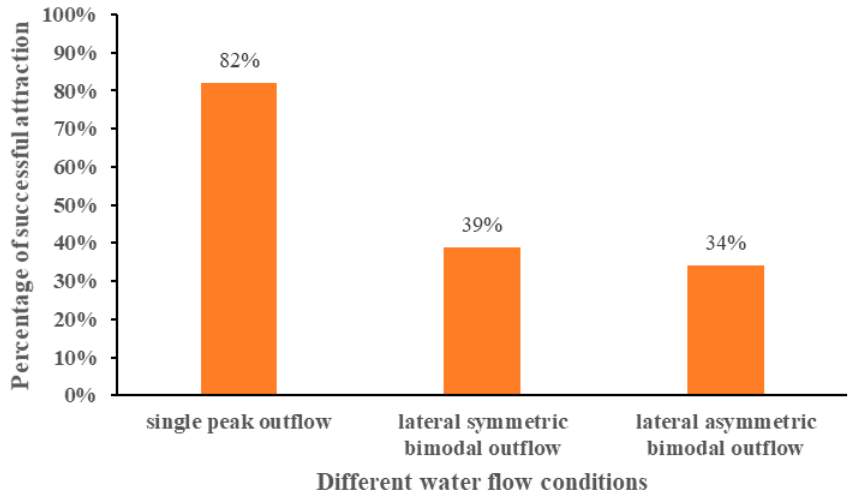
Figure 10. Average attraction success rate under different water flow conditions. Table 2. Analysis of variance (ANOVA).